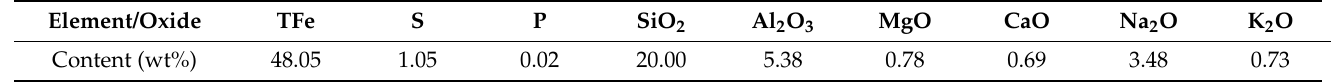
Table 1. Results of main chemical element/oxide analysis on cyanide tailings.